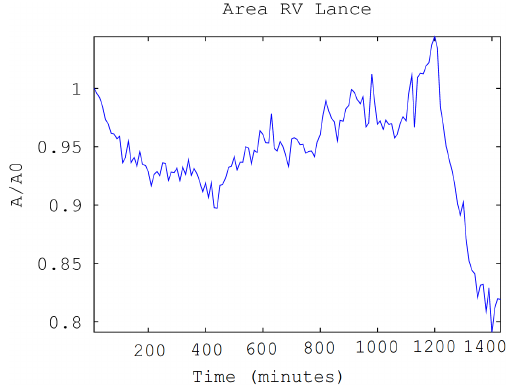
Figure 17. Ratio of the area of the triangle formed by the selected three VBs with respect to the area in the beginning of the period for the 2015 RV Lance